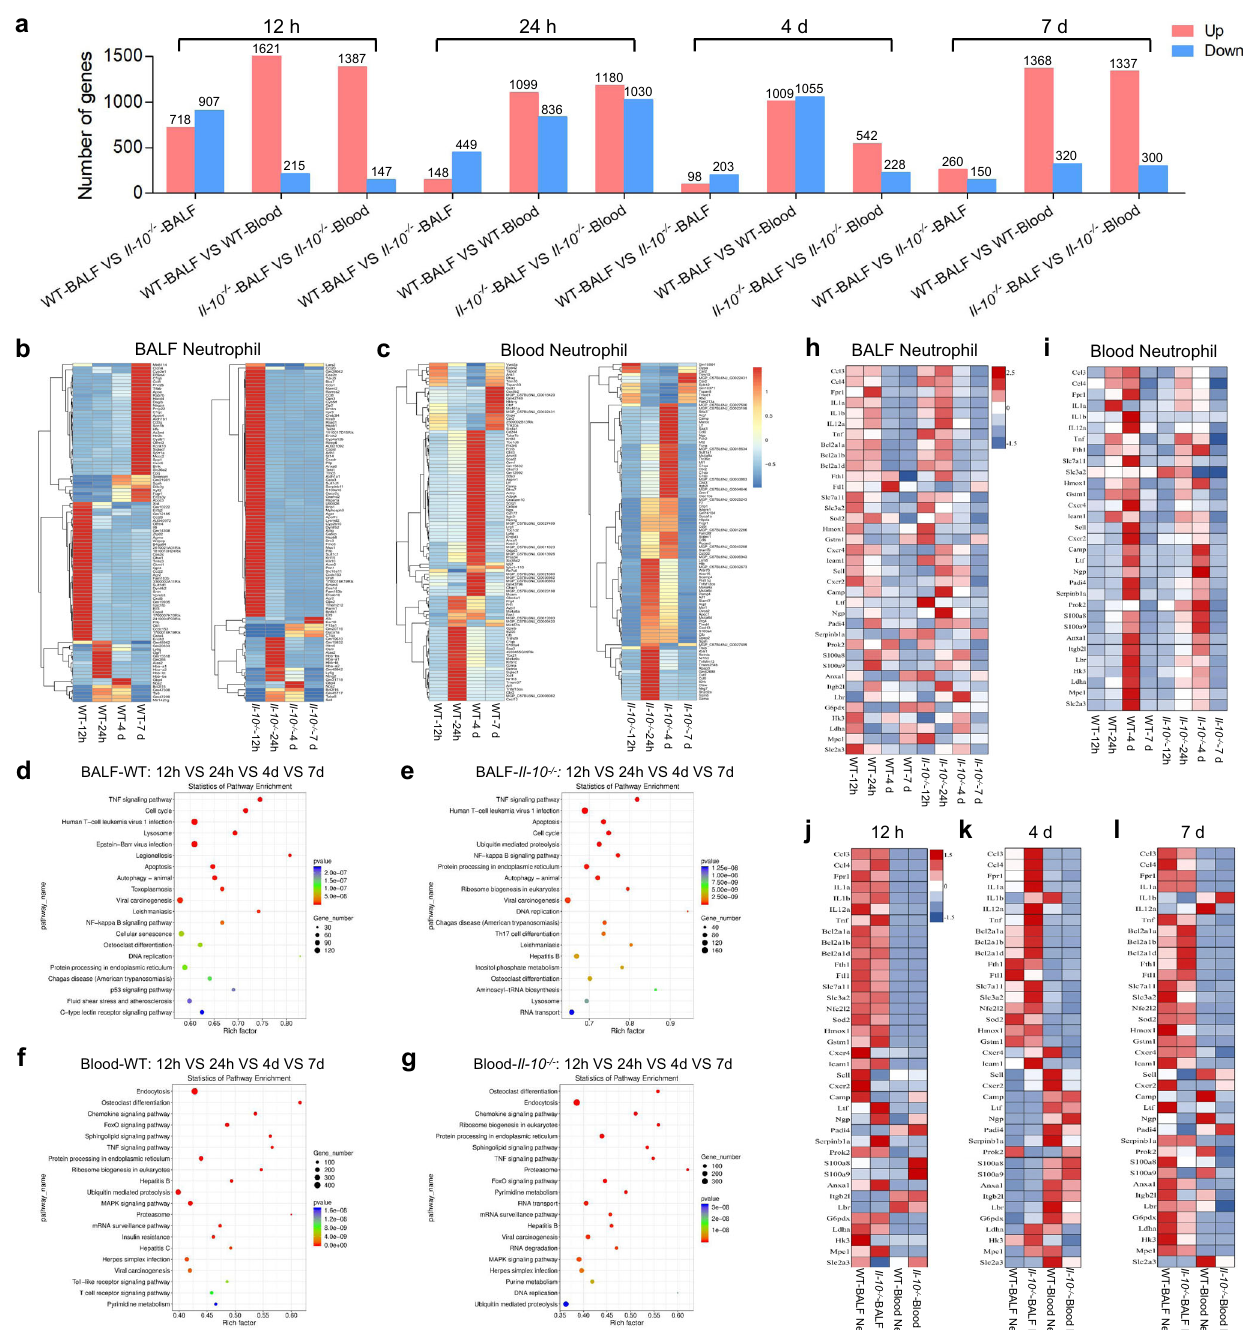
Fig. 8 | Global effects of IL-10 on the transcriptomes of neutrophils extracted from BALF and blood at various time points after LPS stimulation. a Numbers ofdifferentiallyexpressedgenesinneutrophilsfromvariousgroups. b,c Heatmaps showing the most highly differentially expressed genes in BALF ( b ) and blood ( c ) neutrophils from different groups. d – g KEGG pathway analyses of BALF ( d , e ) and blood ( f , g ) neutrophils from different treatment groups. The statistical analysis